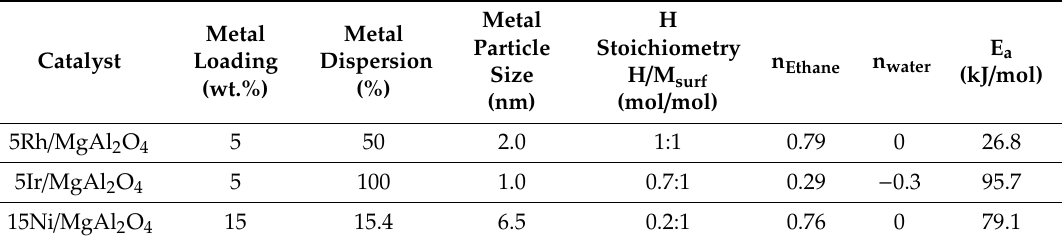
Table 4. Summary of key